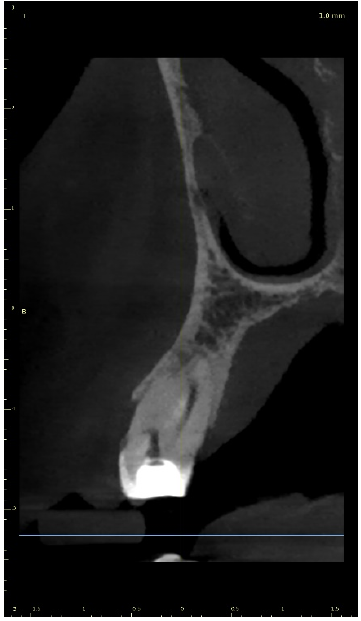
Figure 25. The CBCT image confirmed the calcification of the buccal canal.